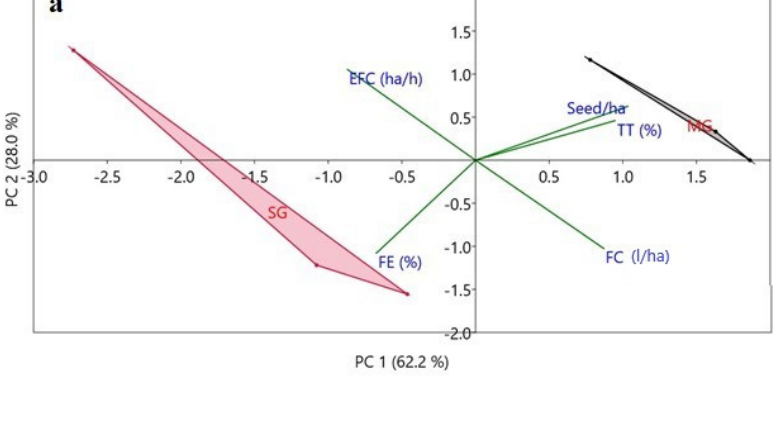
Table 3. Tractor performance semi-automatic guidance (SG).